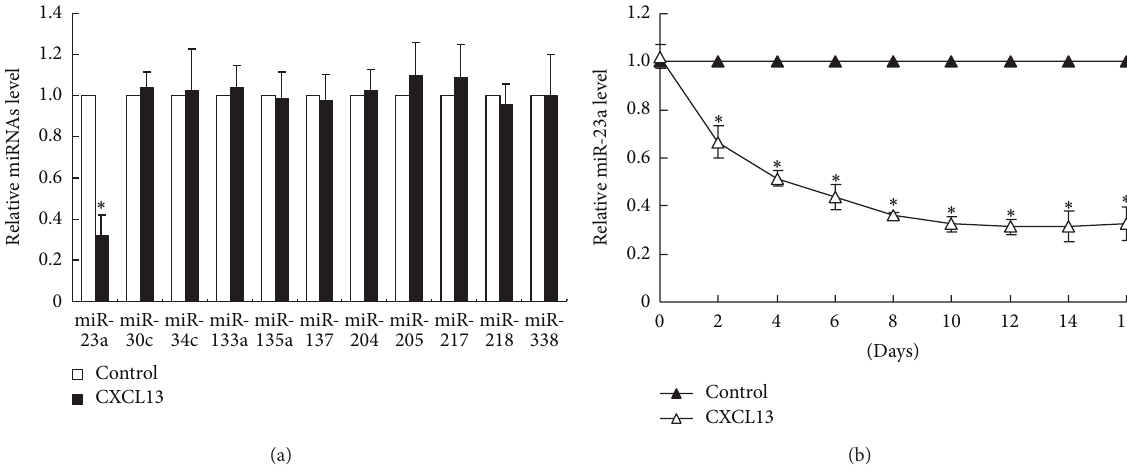
Figure 2: Expression profiles of miRNAs in BMSCs treated with CXCL13 recombinant protein. The cells were cultured in differentiation media with or without CXCL13 recombinant protein for 17 days, (a) miRNA expression levels were analyzed by Q-RT-PCR. (b) Changes in expression of miR-23a over a series of days. Expression was normalized to U6 small RNA and all values represent means ± SD ( 𝑛 = 3 ). ∗ 𝑃 < 0.05 compared with control groups treated without CXCL13 recombinant